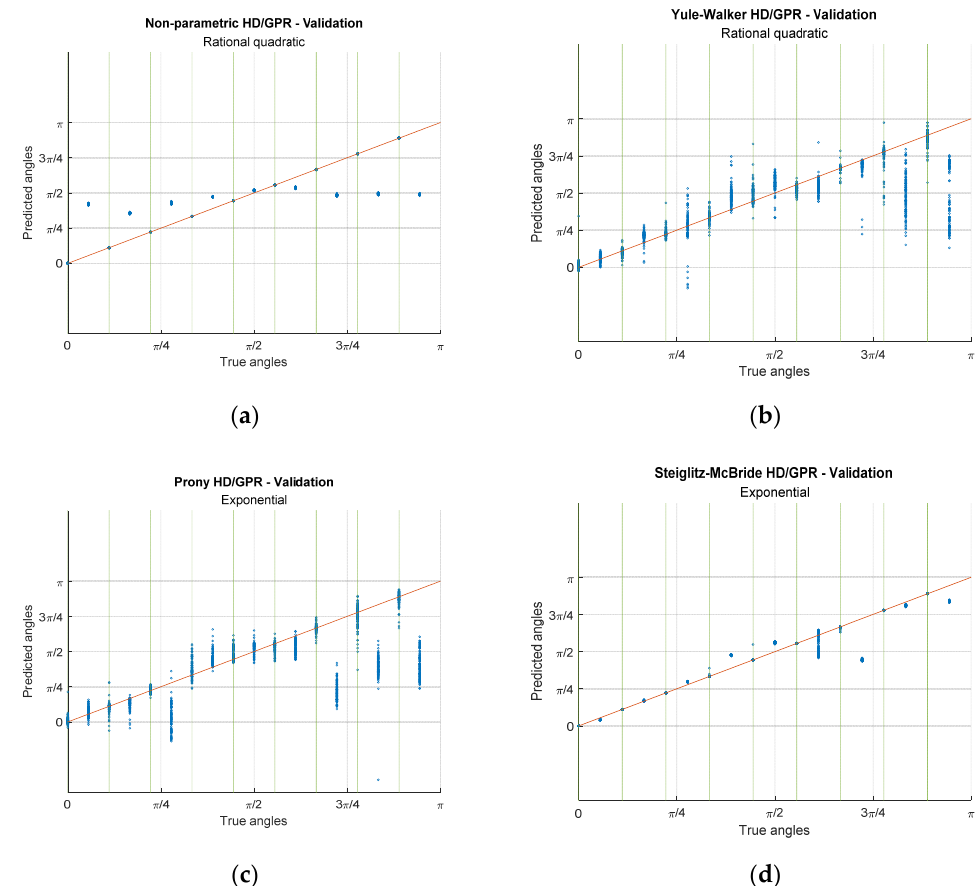
Figure 15. Actual predictions for validation from experiment. The iteration numbers are identical to Figure 13 caption. The green vertical lines show the seen angles. ( a ) Non-parametric HD/GPR— Validation; ( b ) Yule–Walker HD/GPR—Validation; ( c ) Prony HD/GPR—Validation; ( d ) Steiglitz– McBride HD/GPR—Validation.